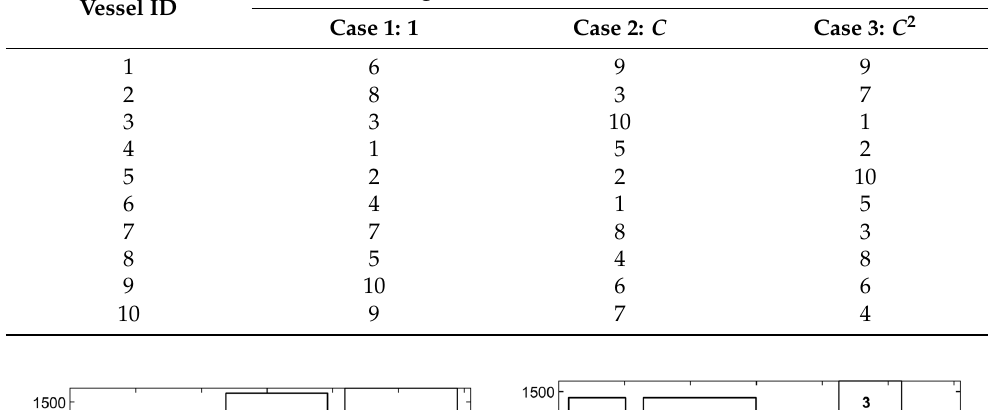
Table 4. Berthing order results under different service priorities.